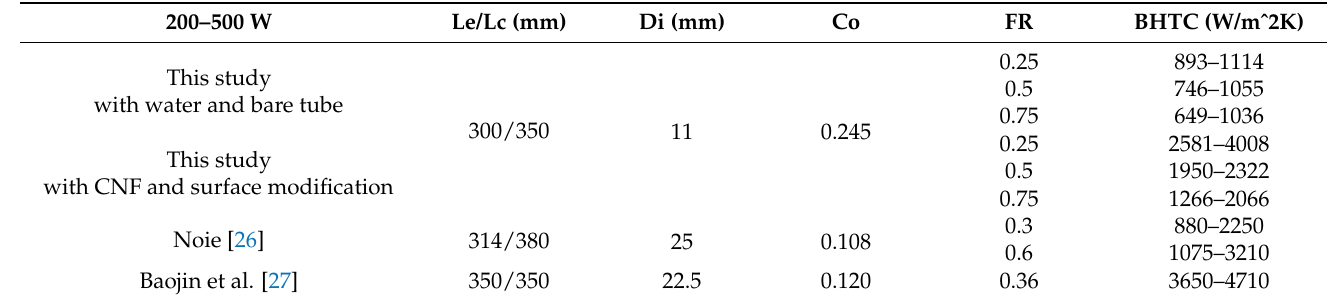
Figure 14. Comparison of boiling heat transfer coefficients with the Rohsenow correlation. Table 4. Comparison with other studies.